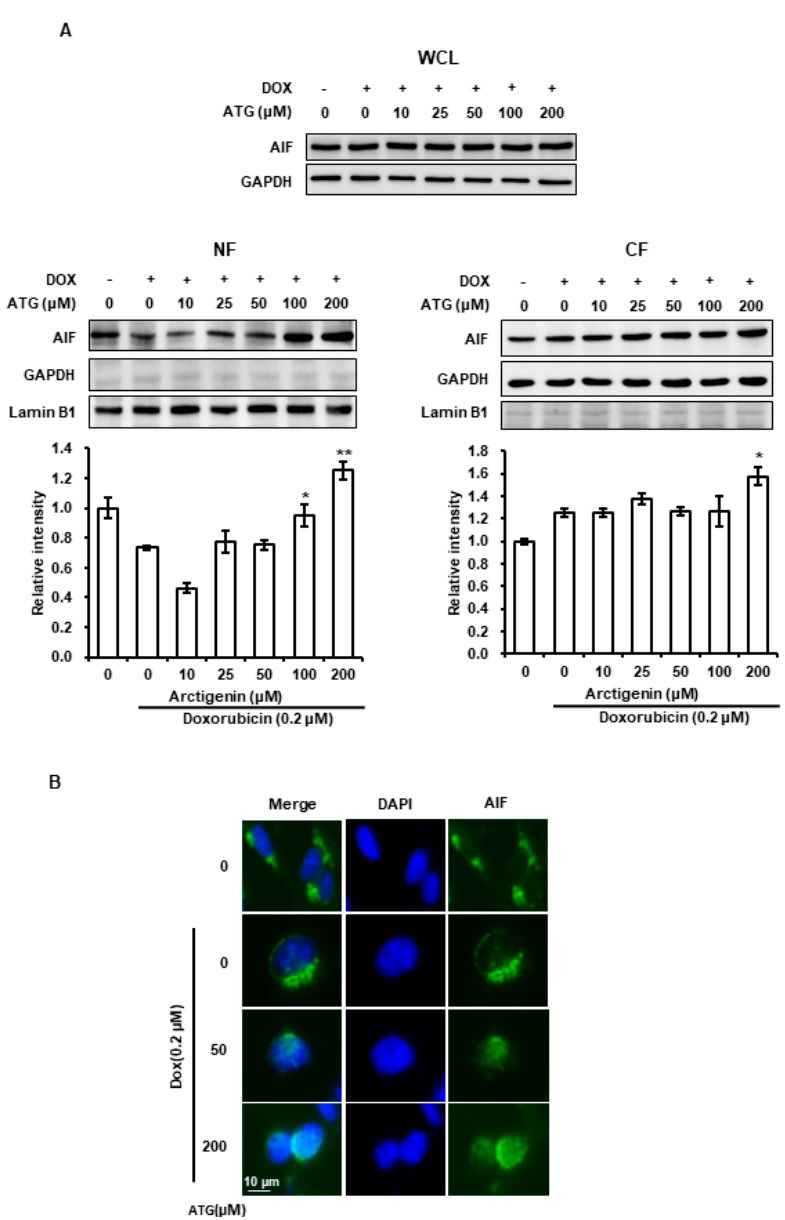
Figure 5. E ff ects of ATG / DOX co-treatment on the nuclear translocation of apoptosis inducing factor (AIF) in MDA-MB-231 cells. (A,B) Cells were attached for 24 h and then co-treated with 0.2 µ M DOX and various concentration of ATG (0–200 µ M) for 72 h in DMEM medium supplemented with 2% FBS. ( A ) Nuclear AIF levels were increased by ATG / DOX co-treatment. Proteins in whole cell lysates and in nuclear and cytosolic factions were separated by 10% or 15% SDS-PAGE and transferred to PVDF membranes. Nuclear and cytosolic fraction bands were densitometrically analyzed using Scion Image software and band densities were normalized versus Lamin B1 and GAPDH, respectively. p < 0.05 and p < 0.005 vs. non-treated controls. *and ** indicate p < 0.05 and p < 0.01 vs. DOX-only. All experiments were independently conducted three times, and results are presented as means ± SDs. − : 0.2 µ M DOX-untreated, + : 0.2 µ M DOX-treated ( B ) After serial fixation with ice-cold methanol and acetone, we immunostained for cellular AIF and nuclei were stained with 4’,6-diamidino-2-phenylindole (DPAI) supplemented antifade mounting solution. Cells were visualized under a fluorescence microscope. ATG / DOX co-treatment was found to promote the nuclear translocation of